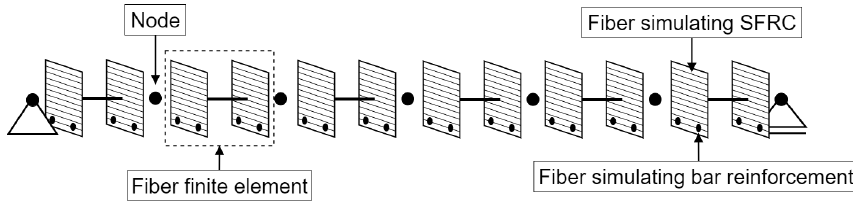
Figure 3. Numerical model set-up.